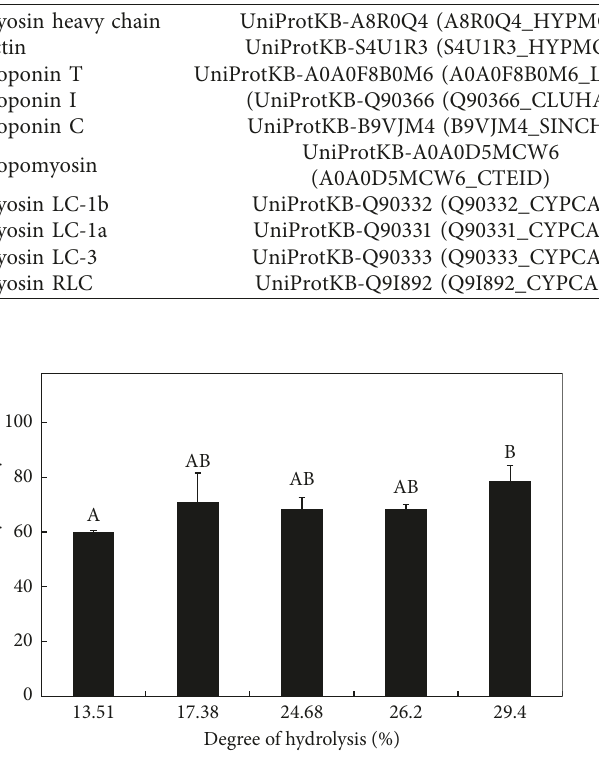
Figure 4: Angiotensin-I-converting enzyme (ACE) inhibitory activity of cryptides obtained from natural actomyosin with dif- ferent degrees of hydrolysis at a peptide concentration of 1mg/ml. Error bars represent the standard deviation from triplicate de- terminations. Different capital letters on the error bars indicate that the results are significantly different ( P 0 . <